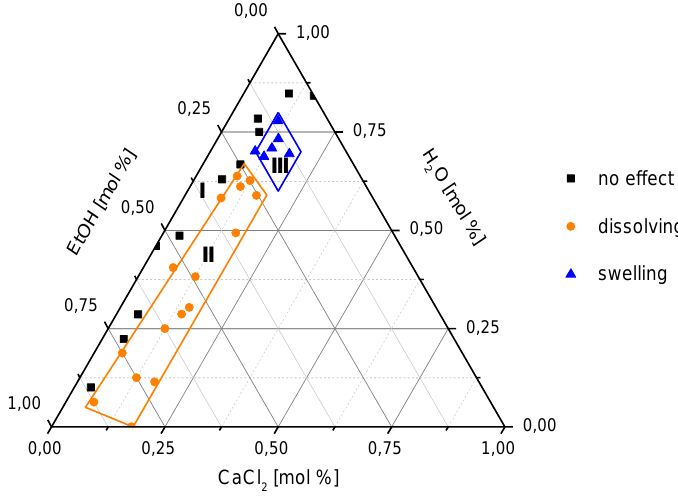
Figure 3. Ternary phase diagram of the CaCl 2 /H 2 O/EtOH system for PA 6.6 fibre treatment.